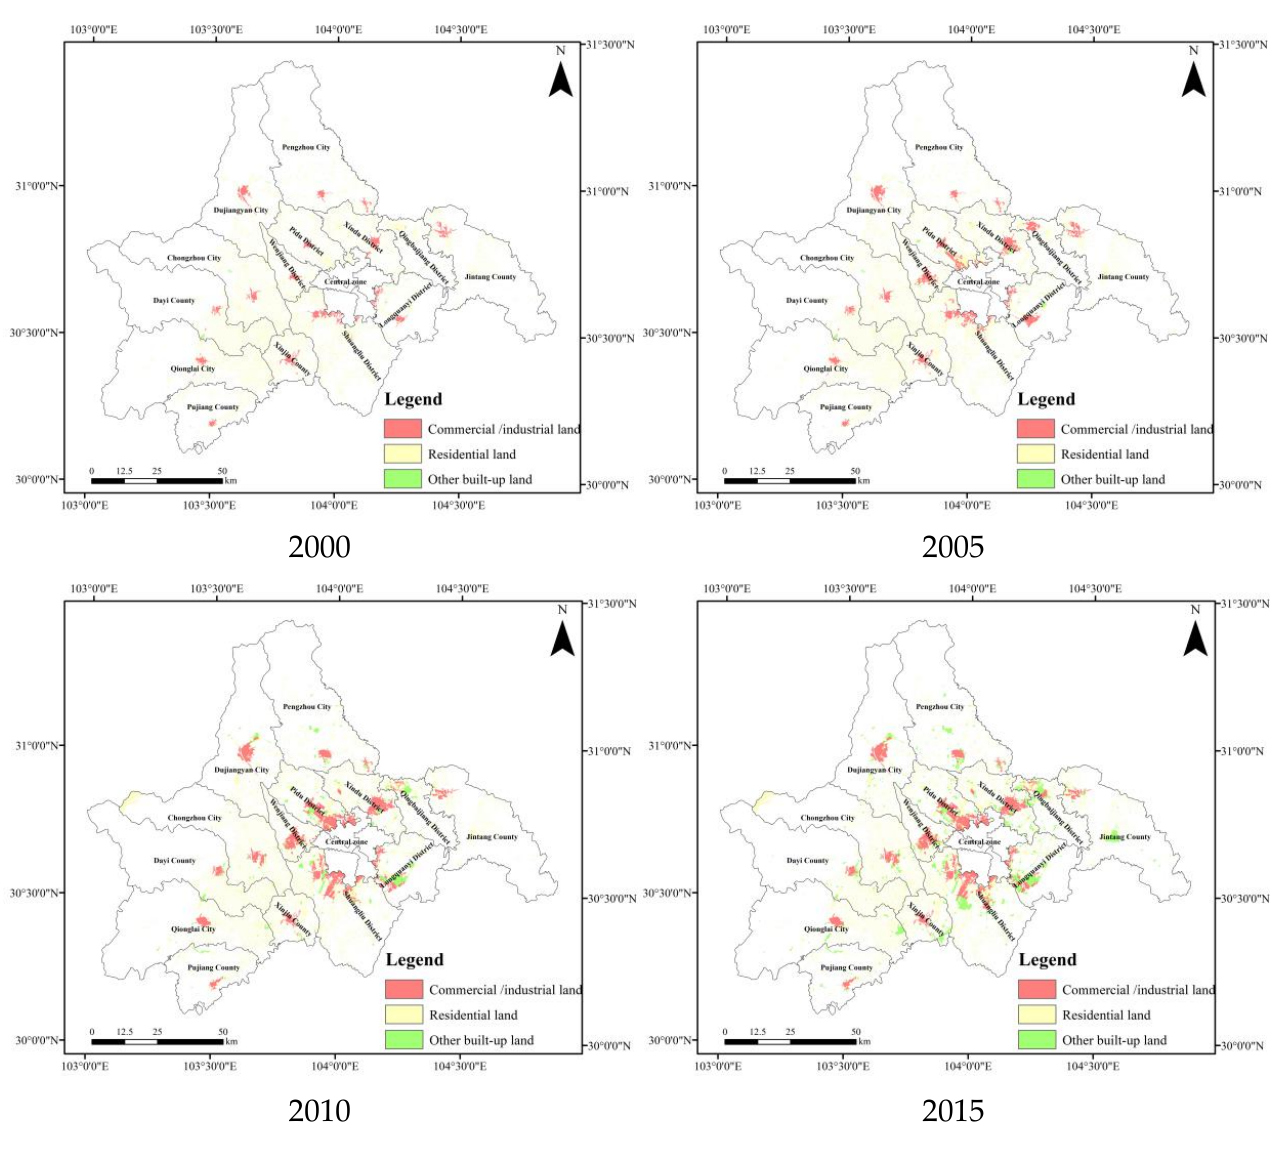
Figure 3. The change in built-up land in the suburbs and exurbs of Chengdu from 2000 to 2015. Boltzmann entropy, the perimeter area fractal dimension (PAFRAC), the contagion degree (CONTAG) and the cohesion index (COHESION) are used to reflect the mutual integration degree of different types of built-up lands in counties of